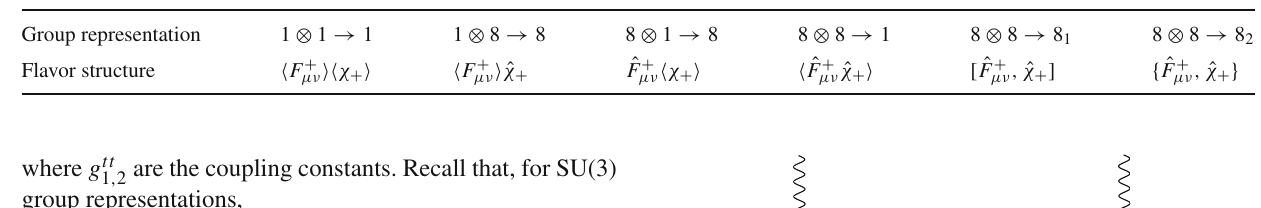
, N MB the number d d